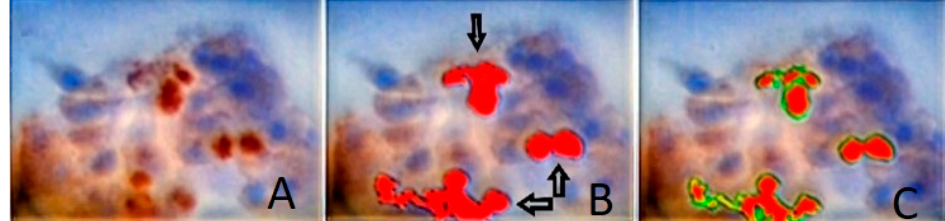
Figure 3. ( A ) Digital image analysis of a pterygia cell spot-stained using FGF-2 antibody (original magnification ×400). ( B ) Different expression values are visible in reddish areas (black arrows). ( C ) Green lines surround specific areas of interest (range: 0–255 grey scale immunostaining intensity levels).